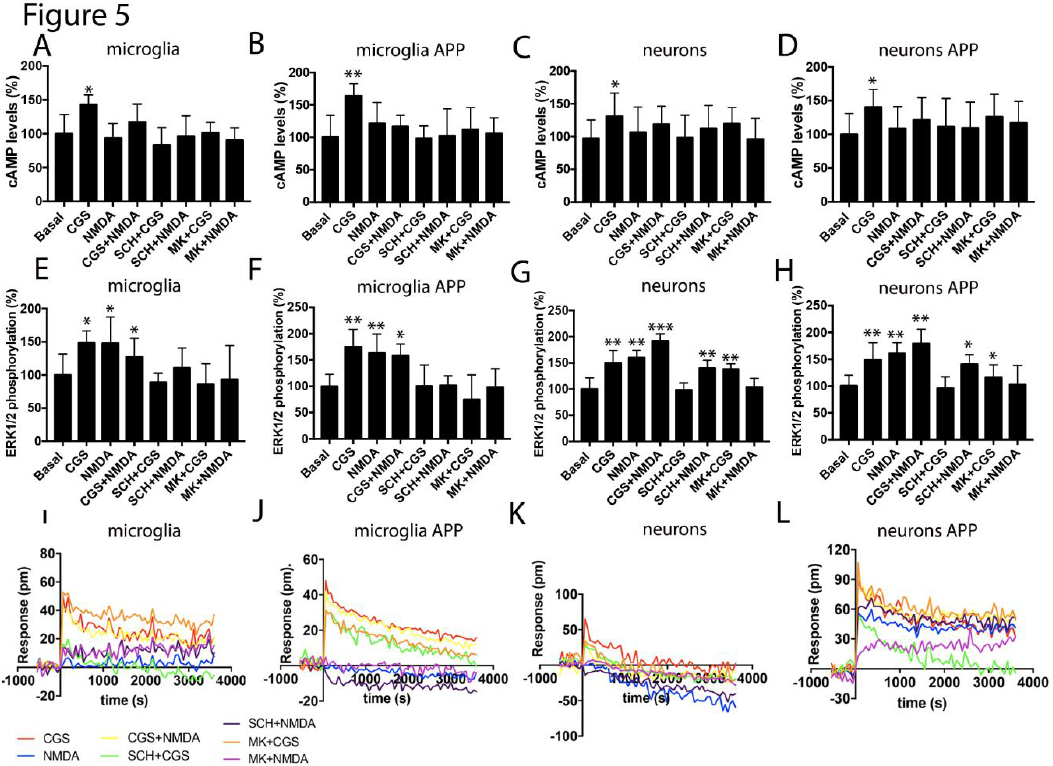
Figure 5. Functionality of the A 2A -NMDA receptor heteromer in the APP Sw,Ind mice model of Alzheimer’s disease(AD). In ( A ) to ( L ), the microglial and neuronal primary cultures from the hippocampus of the WT and APP Sw,Ind mice ( E , H ) were pre-incubated with vehicle, 1 μM of the A 2A R antagonist SCH-58261 (SCH) or 1 µM of the NMDAR antagonist, MK-801 (MK), followed by treatment with 100 nM of the A 2A R agonist CGS-21680 (CGS), 15 µM NMDA or both, and the cAMP levels ( A to D ), ERK 1/2 phosphorylation signal ( E to H ) and the representative traces of dynamic mass redistribution (DMR) over time ( I to L ) were determined. Values are the mean ± SEM of 10 to 12 different experiments. ERK 1/2 phosphorylation levels and cAMP increases are expressed as percentage over basal. A one-way ANOVA followed by a Bonferroni multiple comparison post-hoc test showed a significant effect over basal (* p < 0.05, ** p < 0.01, *** p < 0.001).